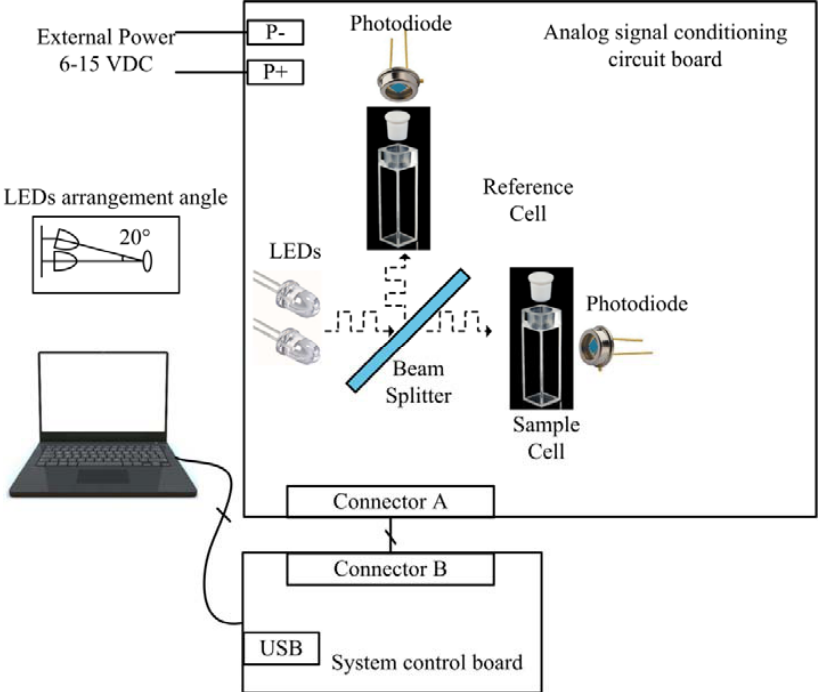
Figure 2. Function block diagram of test system.